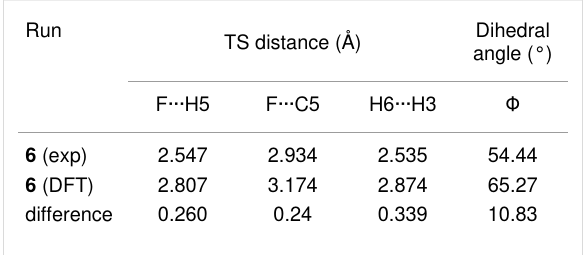
Table 2: Comparison of some features of the X-ray crystal structure and DFT optimized structure of 6 : Through-space (TS) and dihedral angle ( Φ